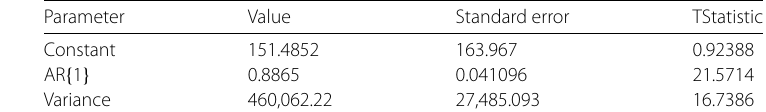
Table 4 Model estimation for deaths in Europe